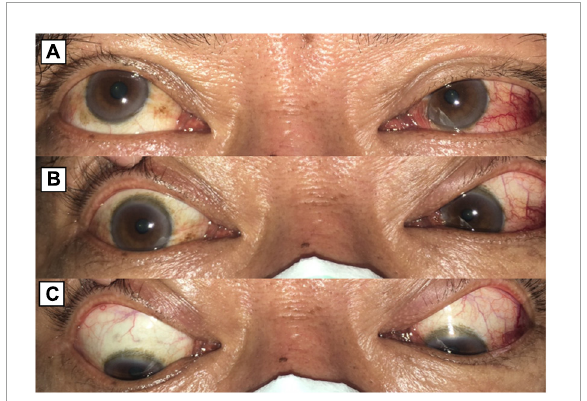
FIGURE1 (A) When looking to the upper right, limitation of abduction of the right eye. (B) When looking to the right, the right eye showed no movement. (C) When looking to the lower right, limitation of abduction of the right